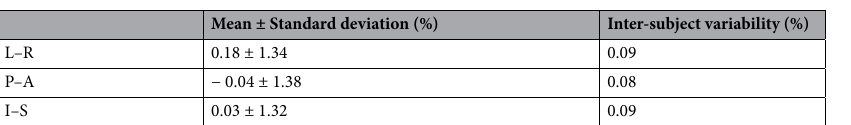
Table 3. Average and standard deviation values of strain in the brain area with the corresponding inter-subject variability along the three main directions.